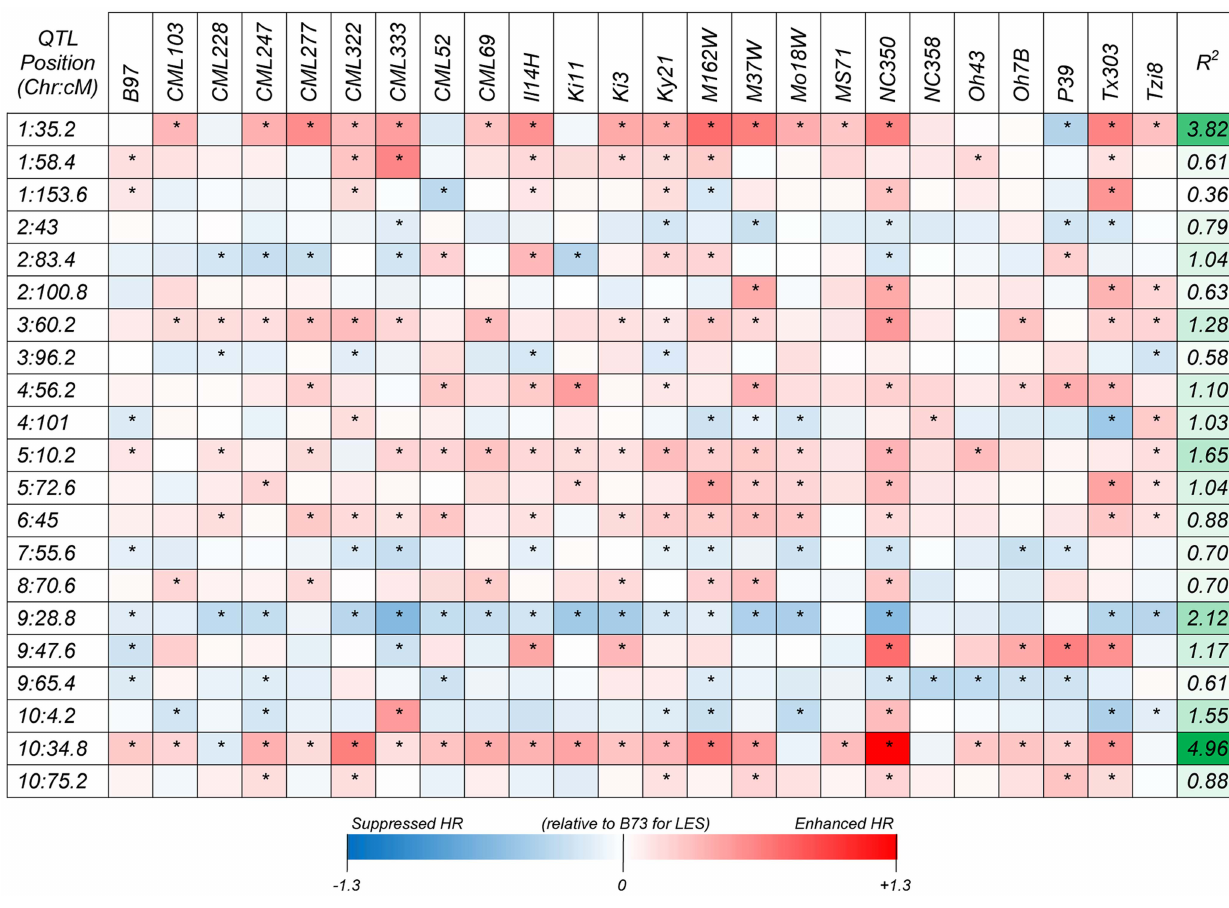
Figure 2. Heat map showing additive allelic effects for the HTR across 24 NAM founder lines relative to the common B73 parent. Chromosome and genetic map positions (centiMorgans; cM) of QTL peaks are shown on the left vertical axis, the contribution to variance among RIL mean values across all 24 NAM populations are shown on right vertical axis and the NAM founder lines are shown on the horizontal axis. Scale below heat map indicates range of allelic effect values and corresponding color intensity. Boxes with asterisks indicate significant ( p , 0.05) allelic